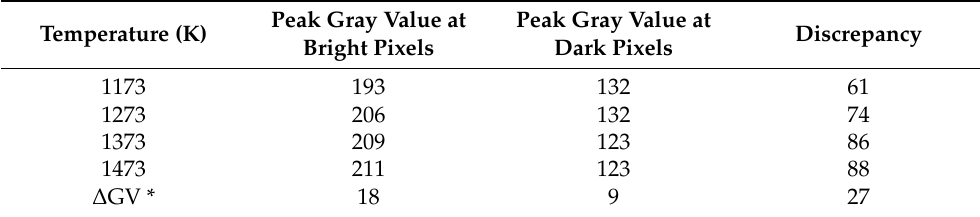
Table 2. Gray Values at Peak Sites in Figure 11 and Discrepancies Between the Bright and Dark Pixels. Peak Gray Value at Peak Gray Value at Temperature (K) Bright Pixels Dark